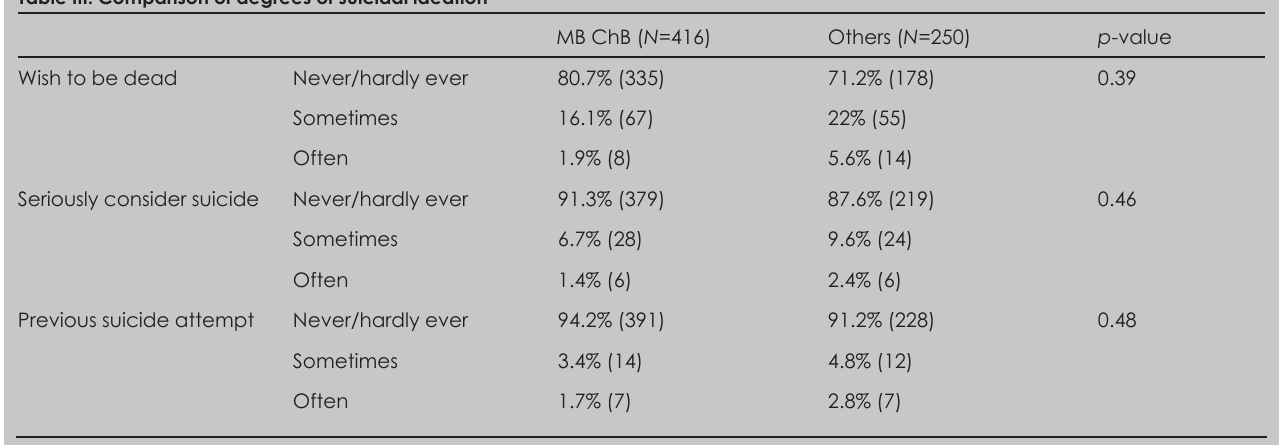
Table III. Comparison of degrees of suicidal